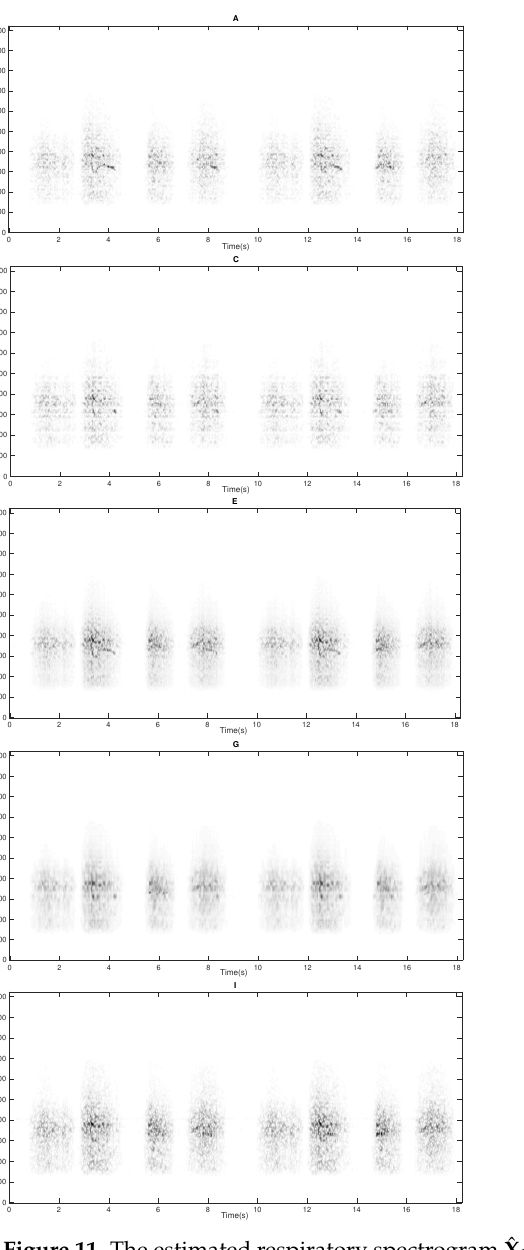
Figure 11. The estimated respiratory spectrogram ˆ X R obtained from the input spectrogram X shown in Figure 1 for the different methods evaluated. ( A ) NMF, ( B ) SNMF, ( C ) SSNMF, ( D ) 2S-NMPCF, ( E ) 1S-NMPCF, ( F ) T-NMPCF, ( G ) CNMF, ( H ) ST-NMPCF, ( I ) IIS 0 -NMPCF and ( J )